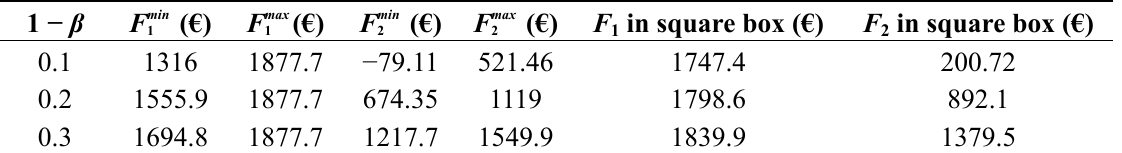
Table 4. Maximal and minimal values of single objectives and best compromise values of F1 and F2.